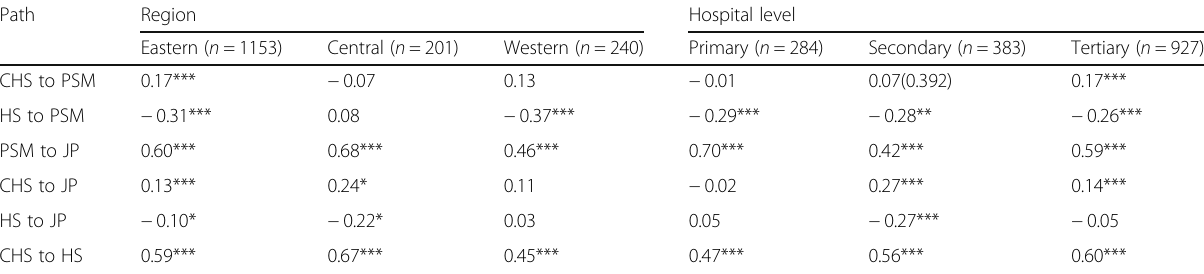
Table 6 Standardized regression coefficients ( β ) with p values for the components of subgroup analyses between different regions and hospital